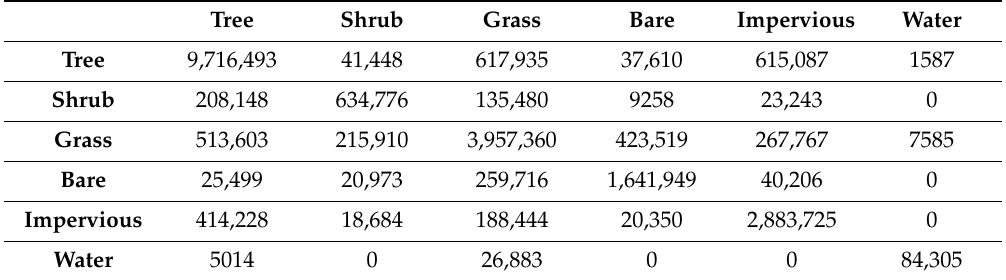
Table 14. Confusion matrix (with median frequency class weights, Oregon—6 classes).